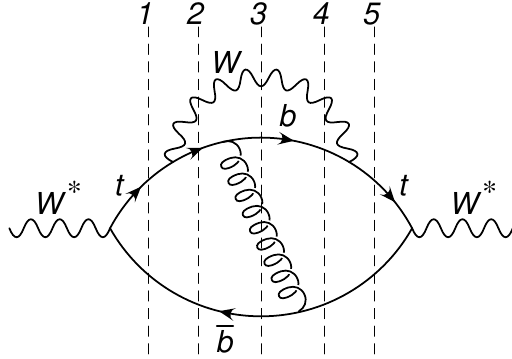
Figure 16 . One time-ordered graph contributing to the W (cid:3) ! t (cid:22) b ! Wb (cid:22) b cross section. conservation. In (cid:12)gure 16 we show a possible time ordering for one graph contributing to the W (cid:3) ! t (cid:22) b ! W b (cid:22) b cross section. The corresponding contribution to the cross section